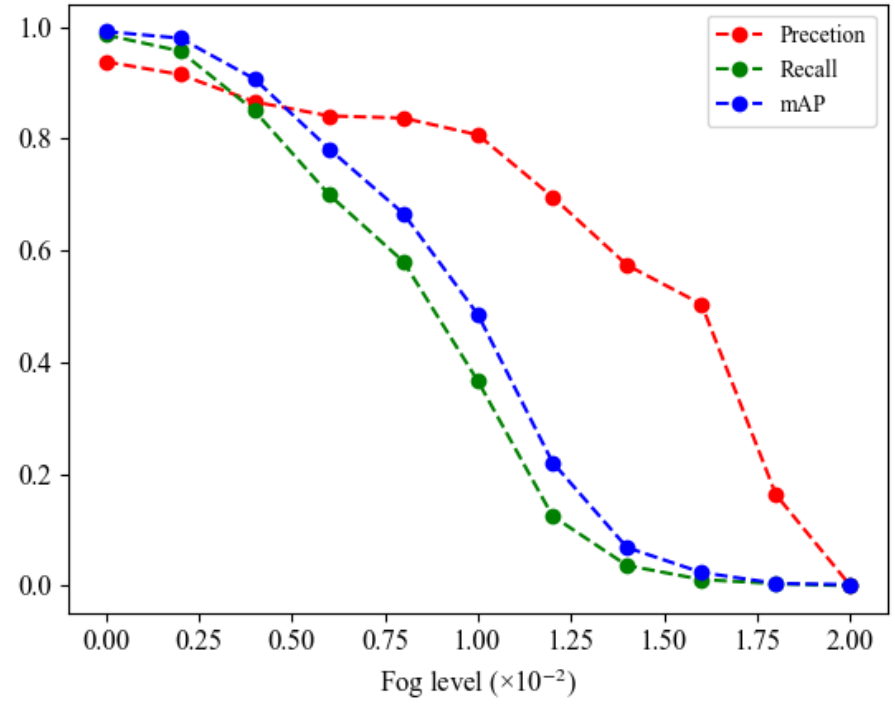
Figure 6. Detection accuracy of YOLOv5 on fog blur